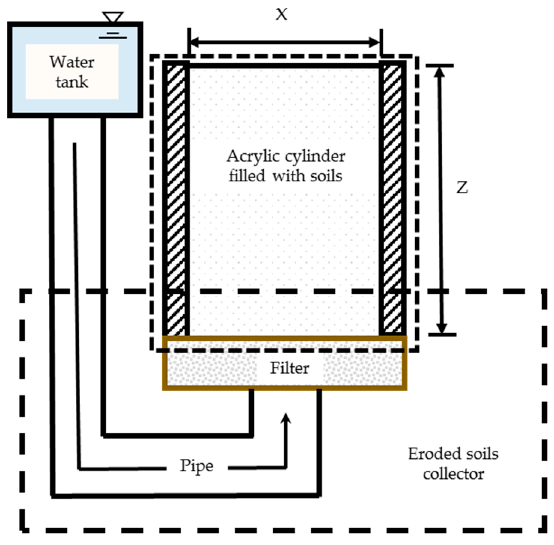
Figure 5. Designs of experimental devices.